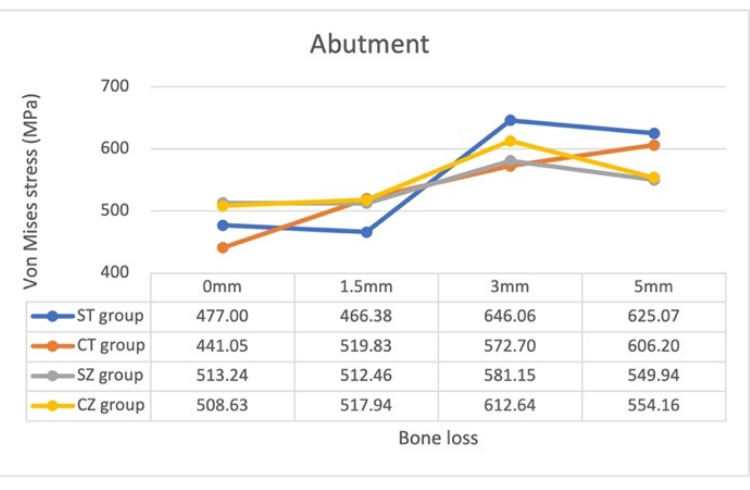
Figure 7. Maximum von Mises stress on the abutment in the 16 models.